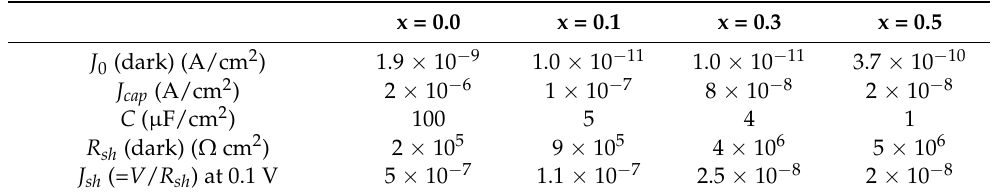
Table 3. The measured parameters from the dark J-V curves of lead halide